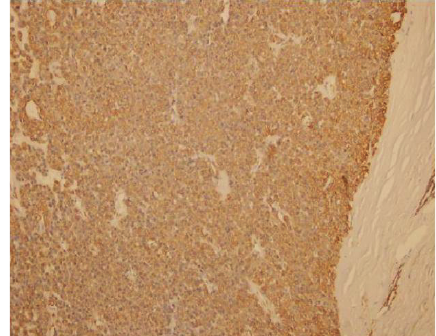
Figure 2: Tumoral cells staining with SMA.